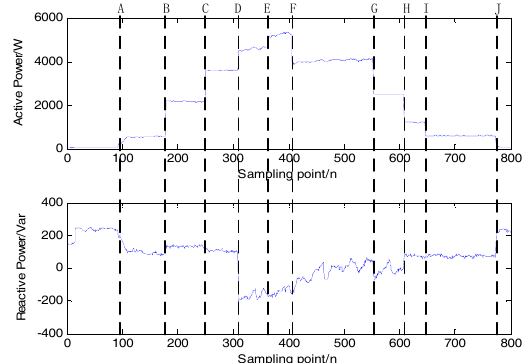
Figure 6. The active and reactive power during the load turning on or off. Table 2. The description of the load event for the test.